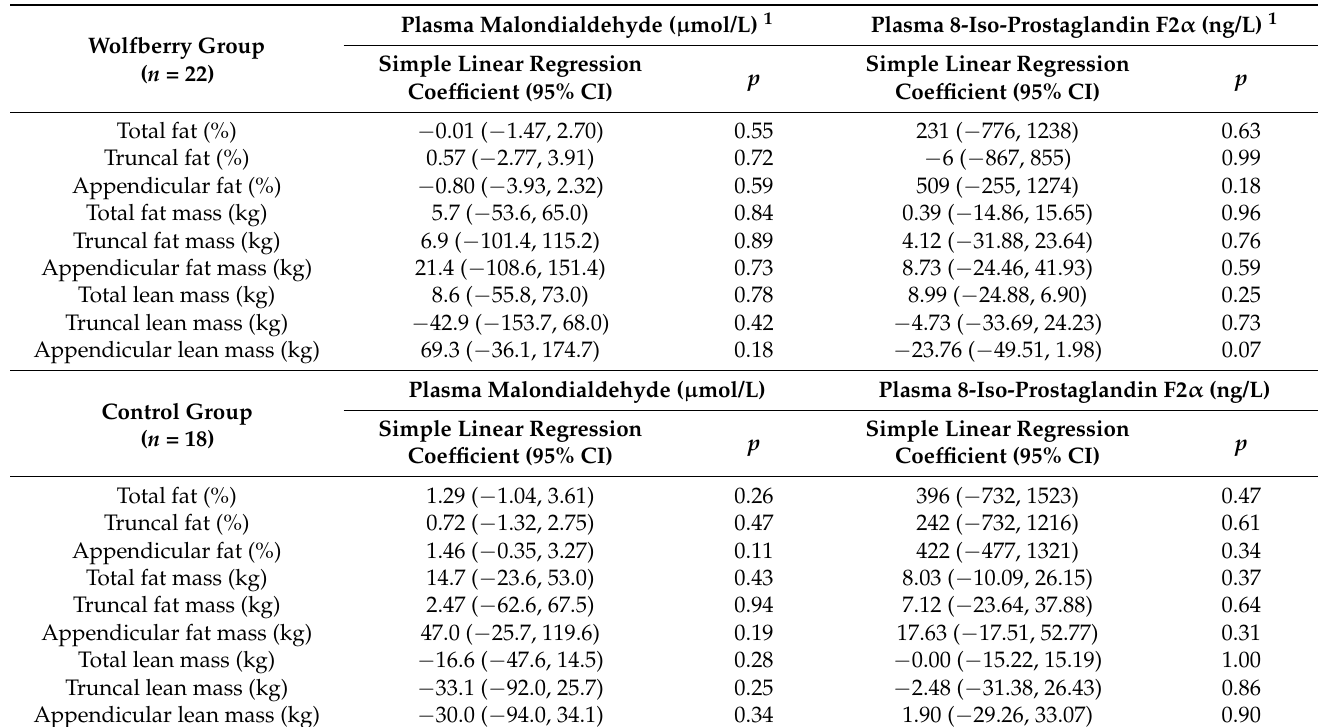
Table A4. Association between change values of body compossition with corresponding changes in the biomarkers of oxidative stress by intervention